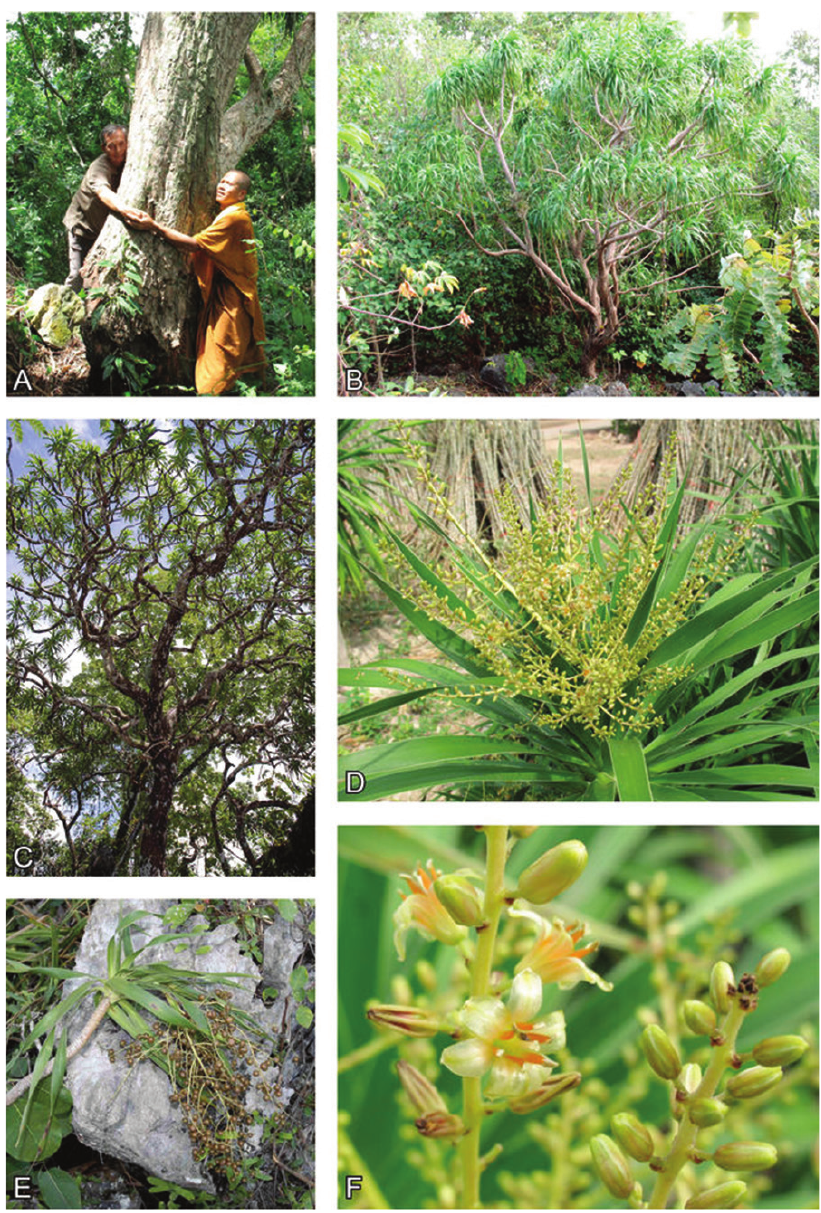
Figure 3. Photographs of Dracaena kaweesakii showing its habit and reproductive morphology. A Trunk base of large individual showing and corky, fissured surface B habit of relatively small individual C habit viewed from below showing the rich branching D Fertile shoot apex showing the white leaf margins and bearing an inflorescence E Branch apex with infructescence rendered pendent by weight of fruit, narrow branch diameter and leaf scars F Flowers on partial inflorescence showing tepal, stamen and gynoecium orientation, shape and colour and axis indumentum. Photographs by Warakorn Kasempankul/Parinya Siriponamat ( A, B, D, F ) and Paul Wilkin ( C, E